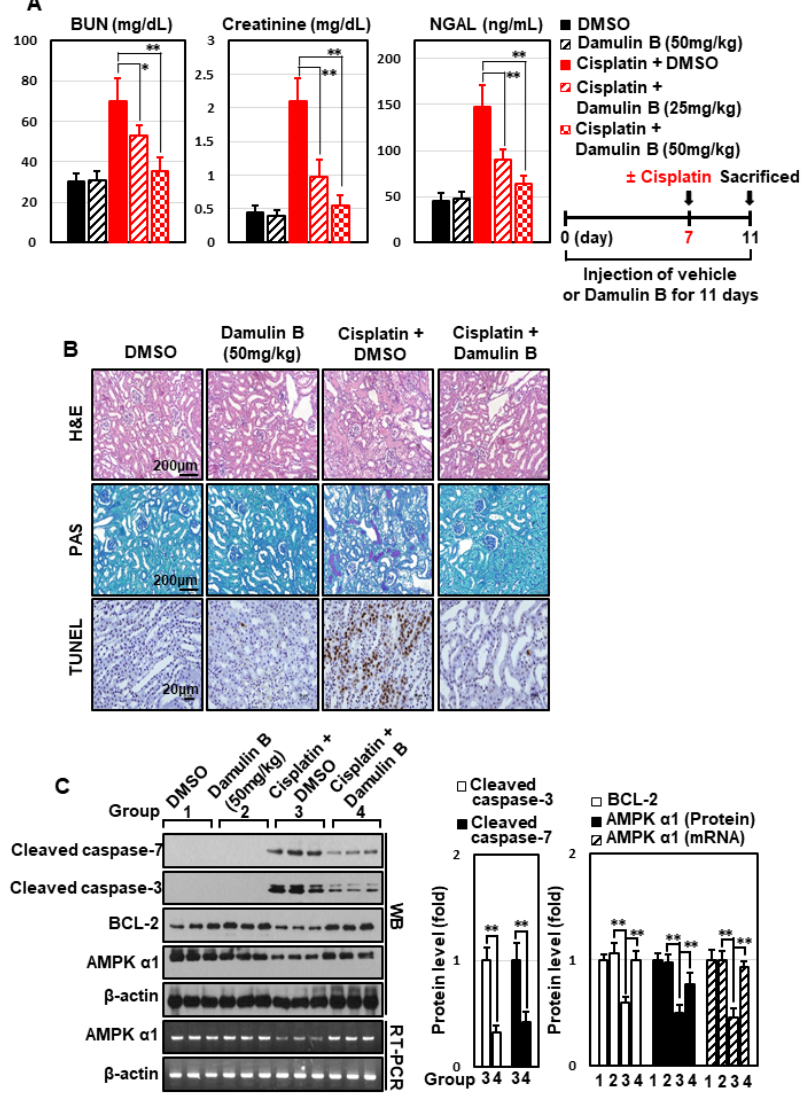
Figure 8. Damulin B prevents cisplatin ‐ induced AKI in mice. Mice were intraperitoneally injected with damulin B (25 or 50 mg/kg) or vehicle every day prior to intraperitoneal injection of cisplatin (20 mg/kg). Four days after cisplatin injection, animals were sacrificed. ( A ) Serum BUN, creatinine, and NGAL levels; ( B ) histological examination of kidney tissue via H&E, PAS, and TUNEL staining; ( C ) Western blot analysis of kidney extracts. p ‐ value < 0.05 was considered statistically significant; individual p ‐ values (* p < 0.05; ** p < 0.01) are indicated in figures.